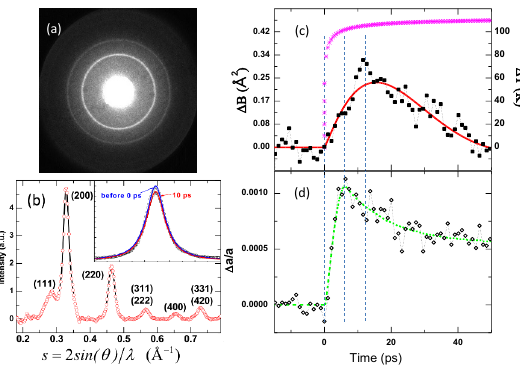
Figure 1. (a) A typical DP of PbSe QDs and (b) the corresponding intensity profile after background substraction. Inset: the intensity profile of (2,2,0) peak at 0 ps (open circle) and 10 ps (open square) after time zero, respectively. The solid curves are fittings by a Lorentz function. (c) The change of DWF (solid square) as a function of time. The solid line is a model fitting. The asterisk line is a simulation of the evolution of carriers’ excessive energy due to Auger relaxation. (d) Relative lattice spacing change (open circle) as a function of time. The dashed line is for guiding viewer’s